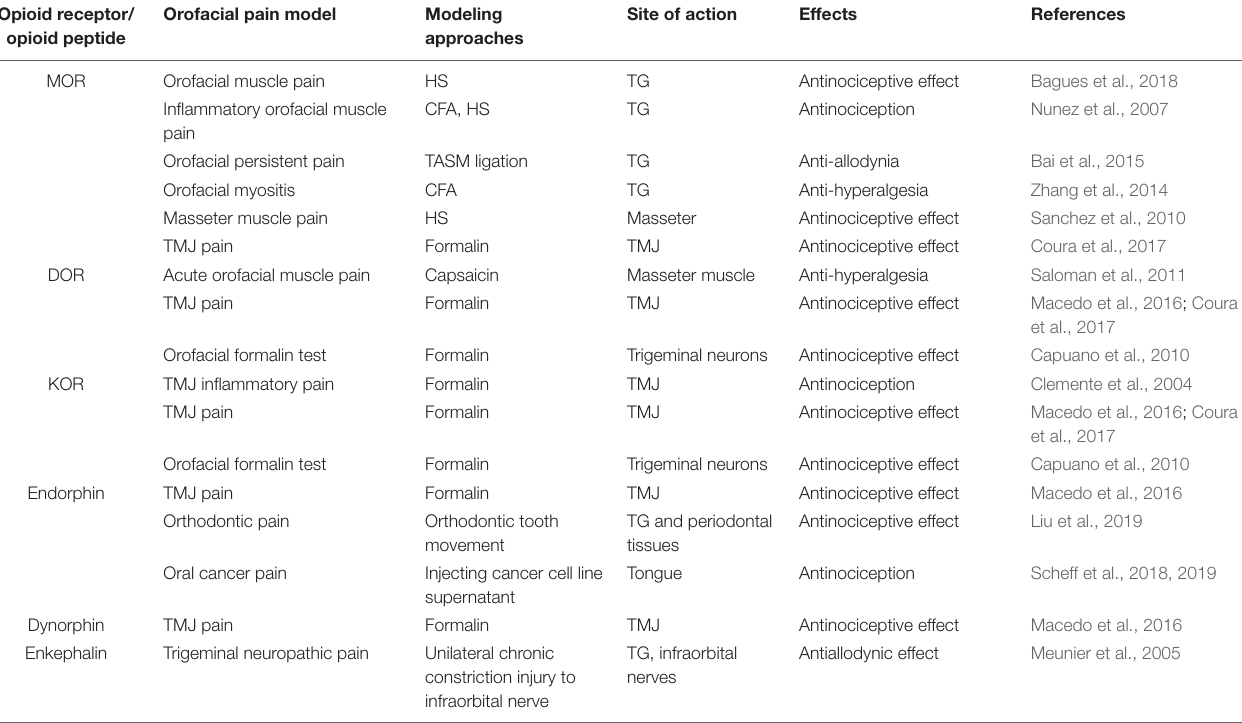
TABLE 3 | The role of EOPs and PORs in orofacial pain modulation. Opioid receptor/ opioid